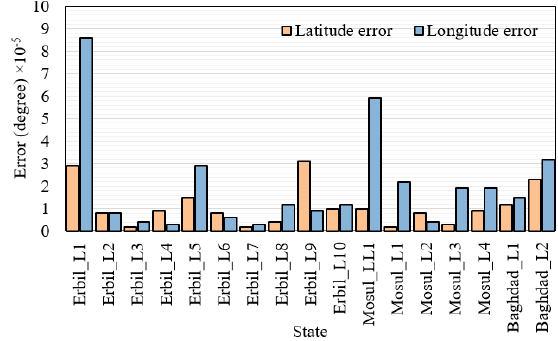
Figure 15. Mean absolute error of the GPS module in terms of latitude and longitude for different locations, (L: location).